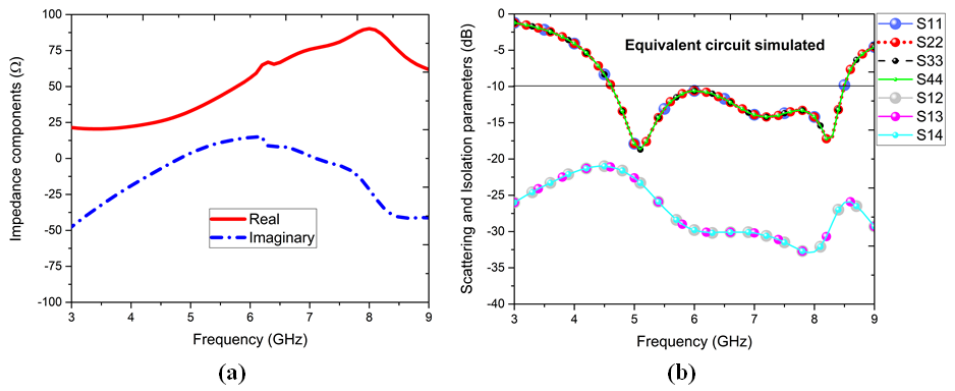
Figure 17. ( a ) Impedance parameters and ( b ) equivalent circuit model (ECM) scattering and isolation coefficients of the four-element antenna